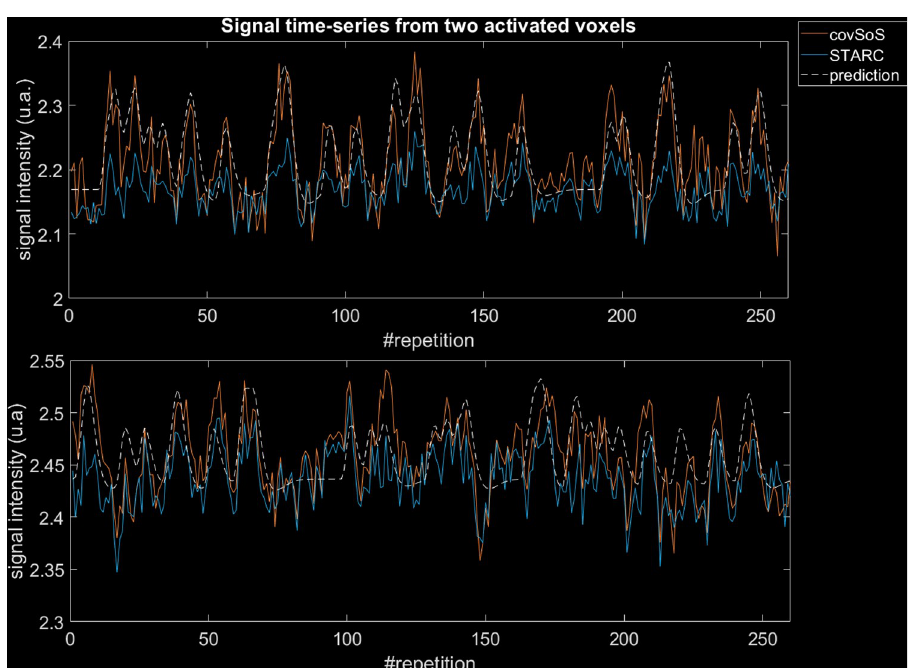
Fig 6. Signal time series for two activated voxels for covSoS and STARC. A time series of the stimuli onset convolved with the canonical hrf is also displayed. Each graph corresponds to a voxel. CovSoS has higher activation peaks than STARC but the latter has the highest